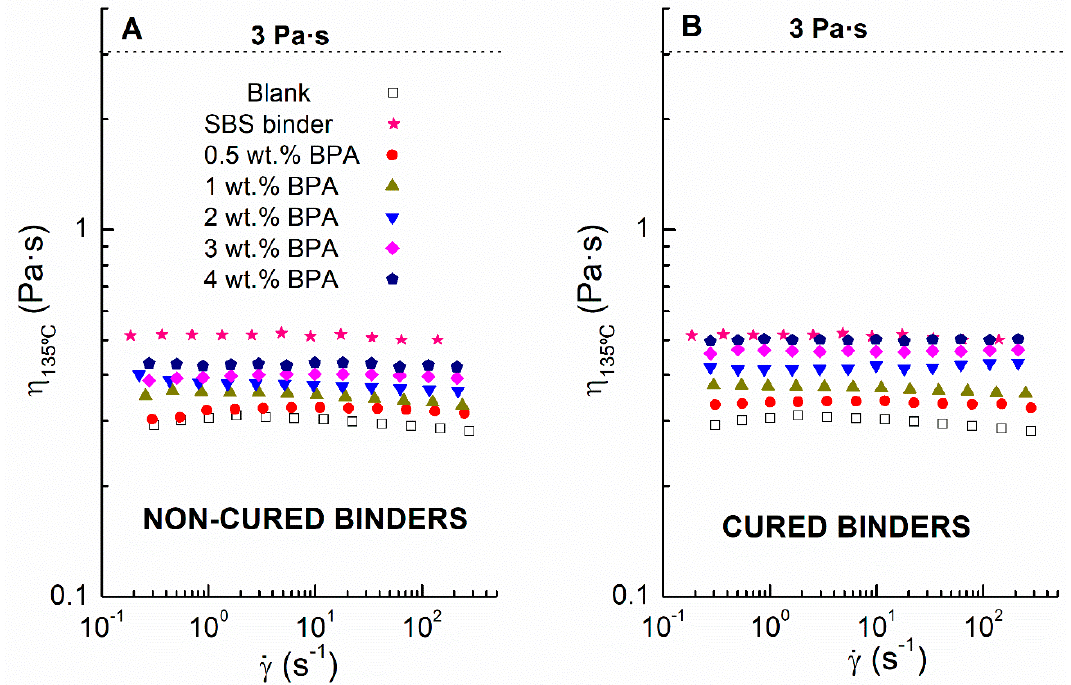
Figure 4. Viscous flow curves at 135 °C of ( A ) noncured and ( B ) cured epoxy modified binders. Comparison with a 3 wt % SBS-modified bitumen and neat bitumen subjected to the same mixing conditions (Blank sample).